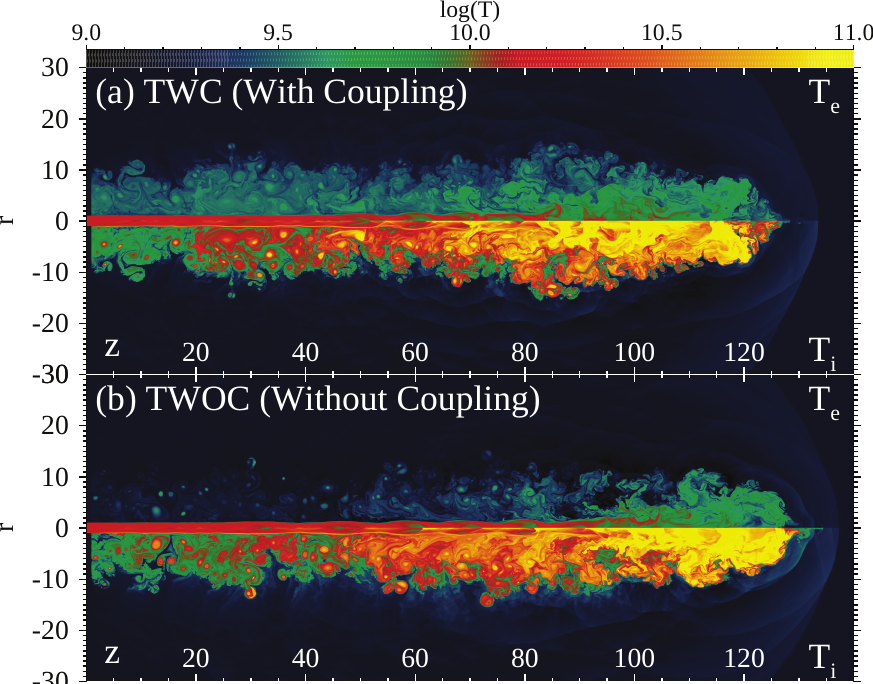
Figure 3. ( a ): the distribution of the electron temperature ( top ) and ion temperature ( bottom ) for model TWC at t = 70 t 0 ; ( b ): same as ( a ), but for model